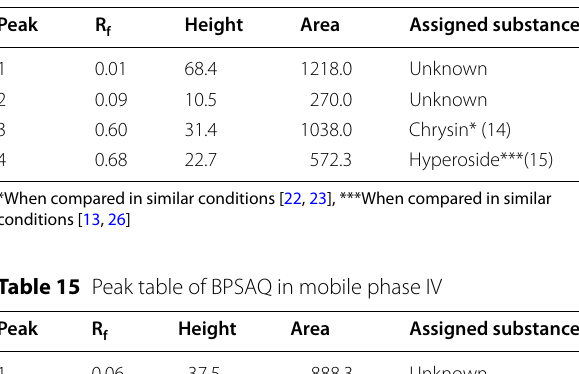
Table 13 Peak table of BPSAQ in Mobile Phase II